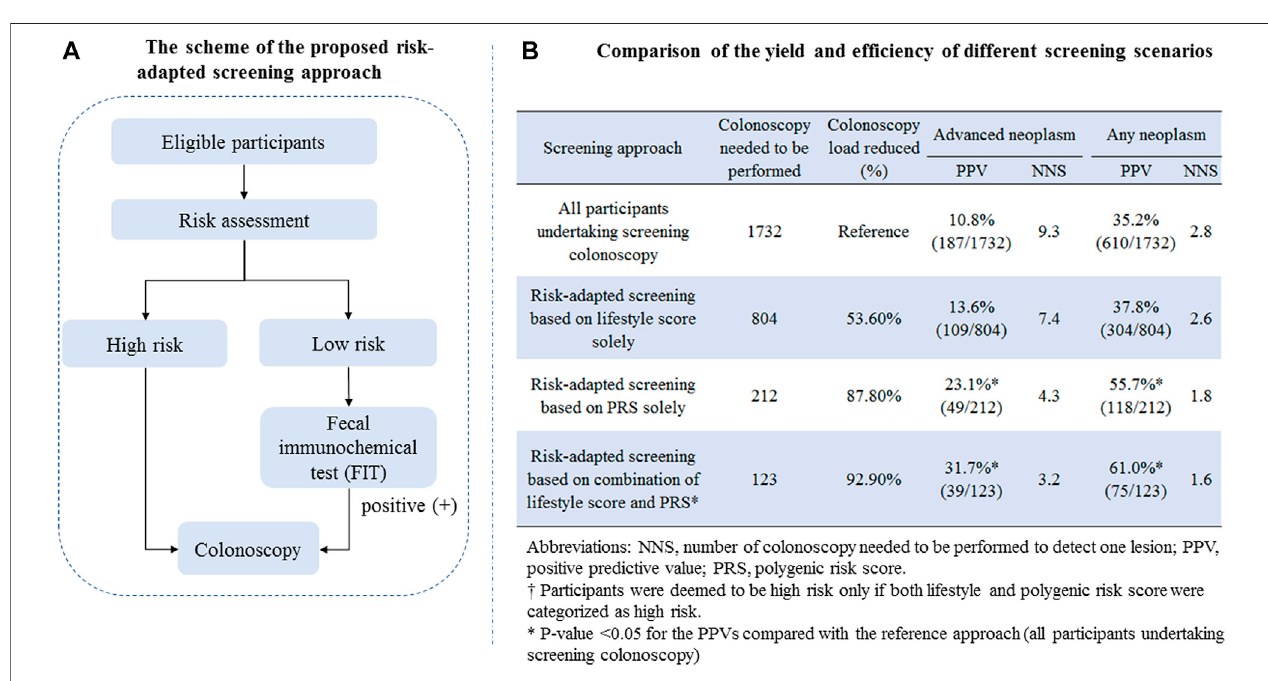
FIGURE 2 | (A) Scheme of the proposed risk-adapted screening approach; (B) comparison of the yield and ef fi ciency of different screening scenarios.